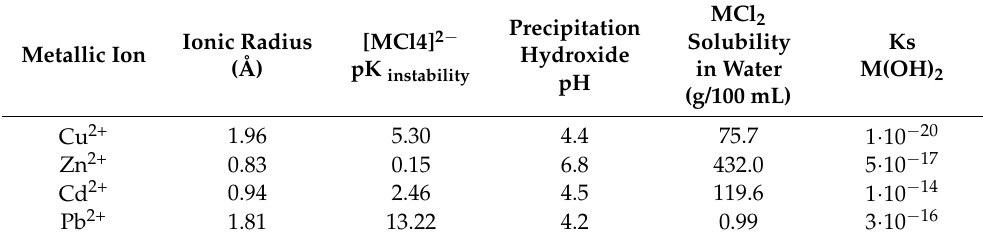
Table 3. The characteristics of the tested metallic ions in aquatic